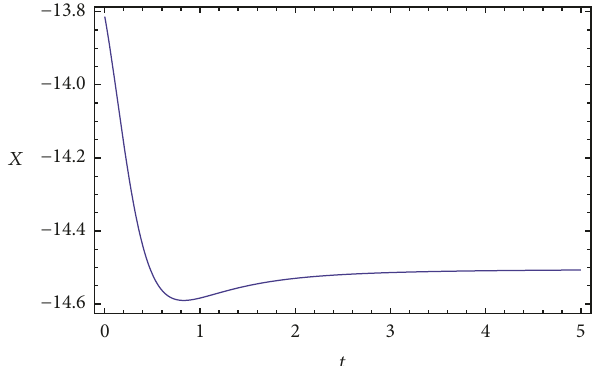
̈𝑆 Figure 6: Plot of 𝑋 = tot by taking Renyi entropy as entropy at apparent horizon, where time is measured in seconds.